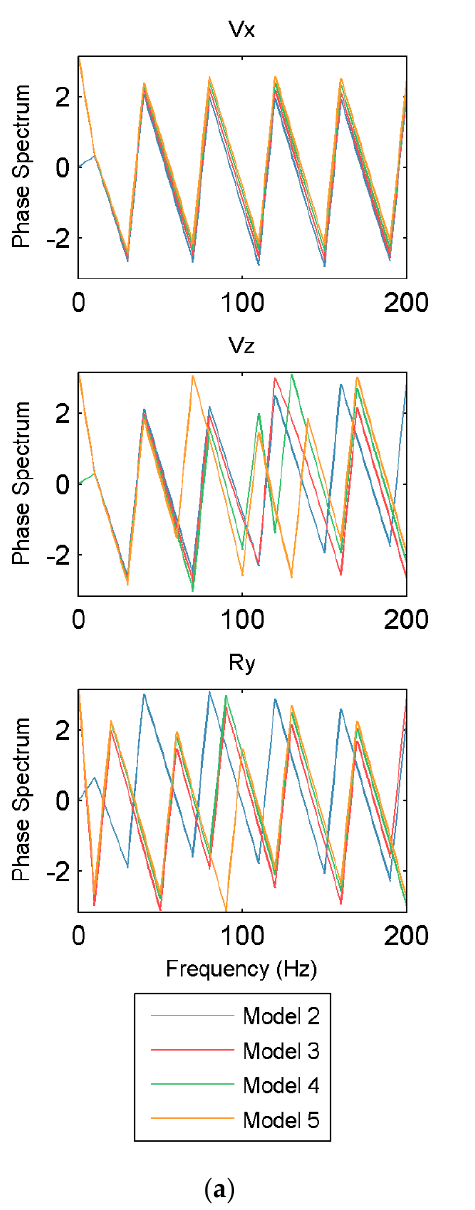
Figure 12. Influence of ε and δ on peak values of the 90th trace generated from the expansion source.